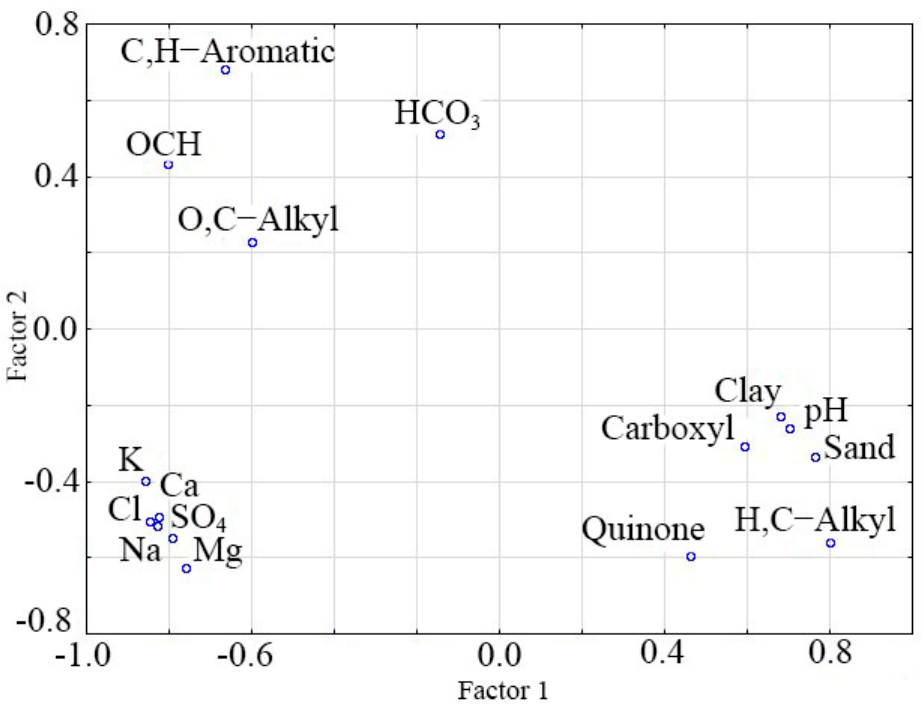
Figure 5. Factor analysis among the main soil parameters and functional groups of humic acids. Data of the main soil parameters were published earlier in the article by Gubin et al. [10].